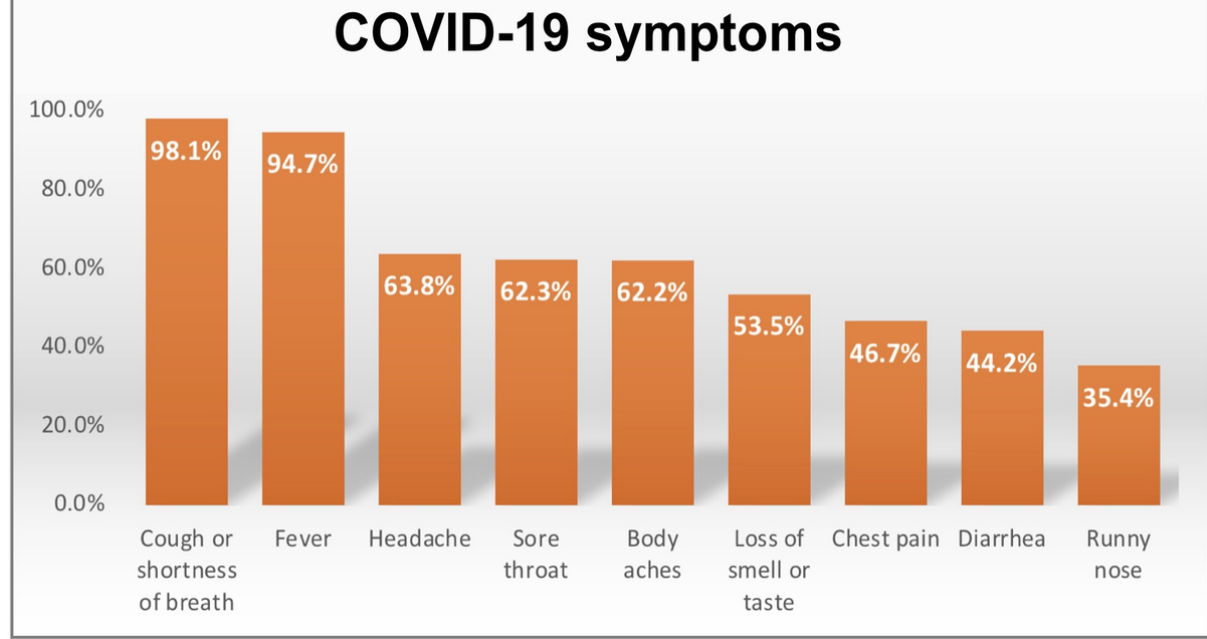
Disagree, n (%)Neutral, n (%)Agree, n (%)Item